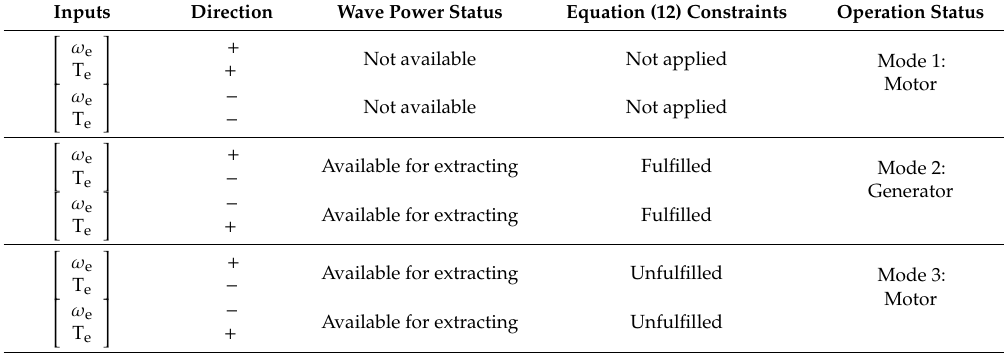
Table 2. Electrical machine operation modes while considering power extracting constraint.